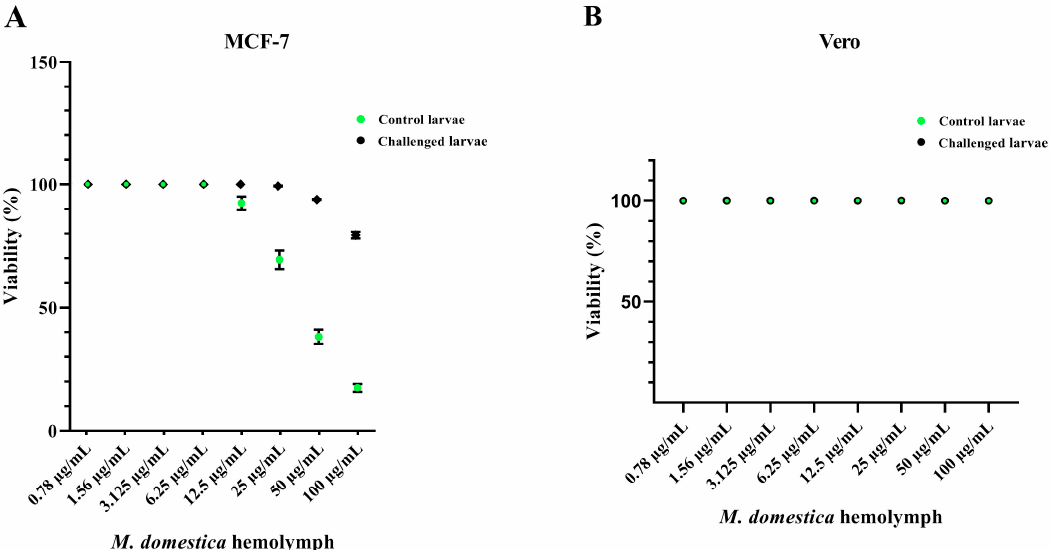
Figure 3. The viability of control and LPS-treated M. domestica larval hemolymph on MCF-7 ( A ) and Vero ( B ) cell lines using the MTT assay. The incubation with serial concentrations (0.78–100 µg/mL) of the tested larval hemolymphs was done in triplicates. Data were represented as (mean ± SD) of three independent experiments.